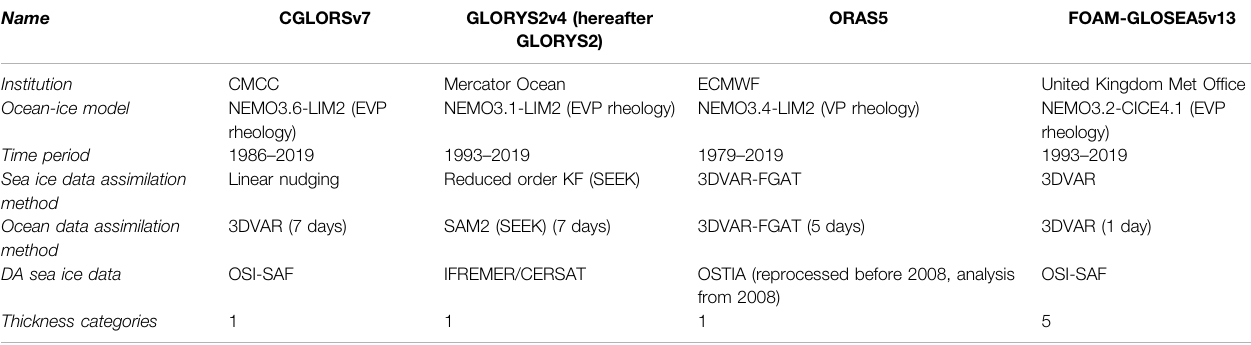
TABLE 1 | The central characteristics of ocean